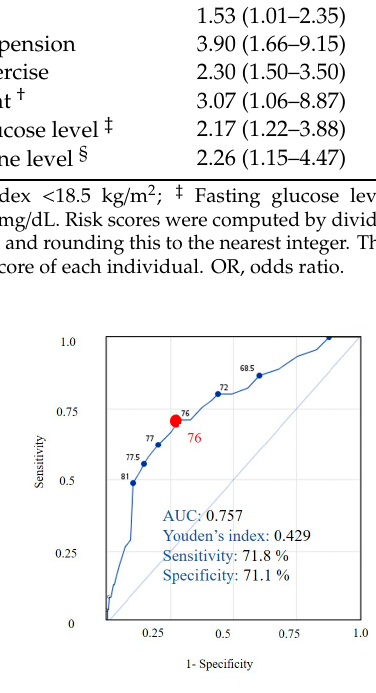
Figure 1. The receiver operating characteristic analysis of the Taiwan Risk Scores for Sarcopenia (TRSS) model. AUC, area under the curve; OR, odds ratio.